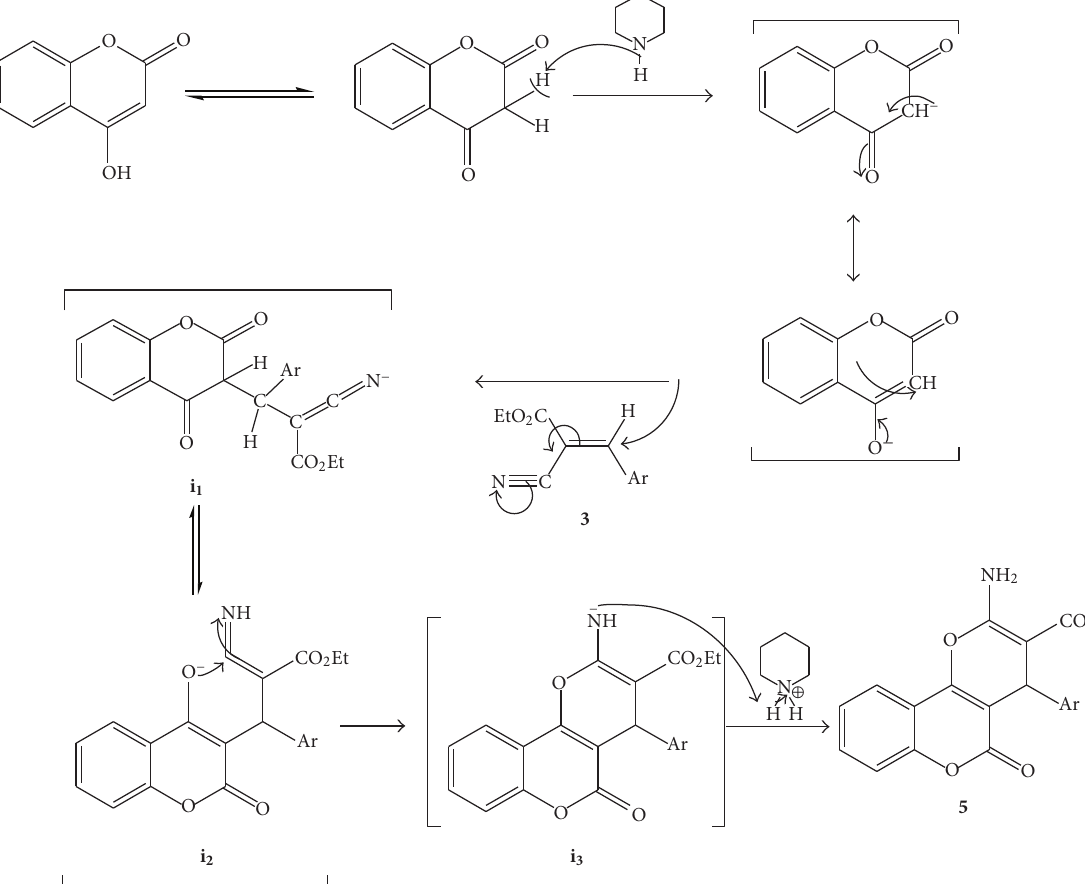
S 3: Proposed mechanism for the synthesis of 2-amino-3-ethoxycarbonyl-4-(aryl)-4H-pyrano-[3,2-c]-chromene-5-ones 5 .